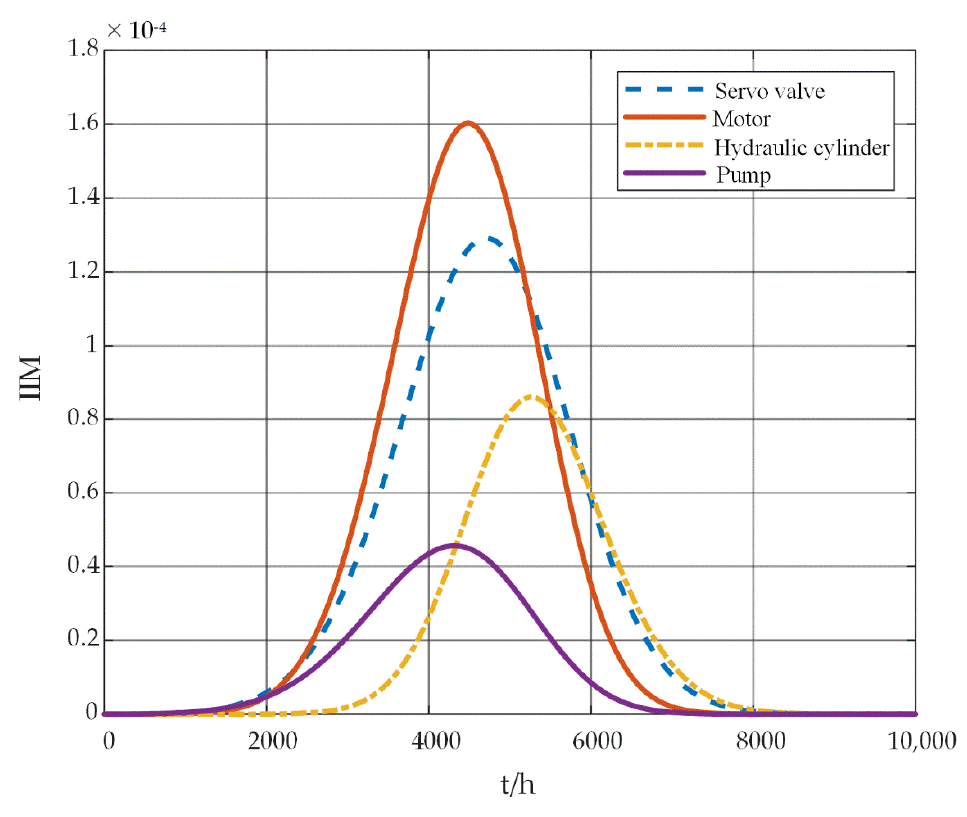
Figure 5. IIM values of the key components in the DRAS change over time.